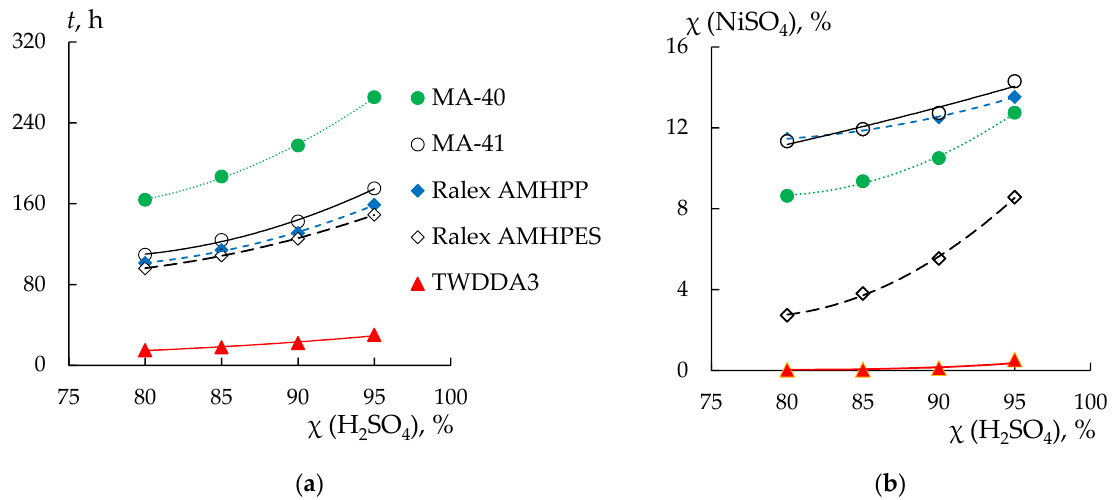
Figure 5. The time of reaching 80–95% recovery of sulfuric acid ( a ) and the loss of nickel sulfate ( b ) for the studied membranes. The signature of the data in the figures corresponds to the signature given in ( a ).